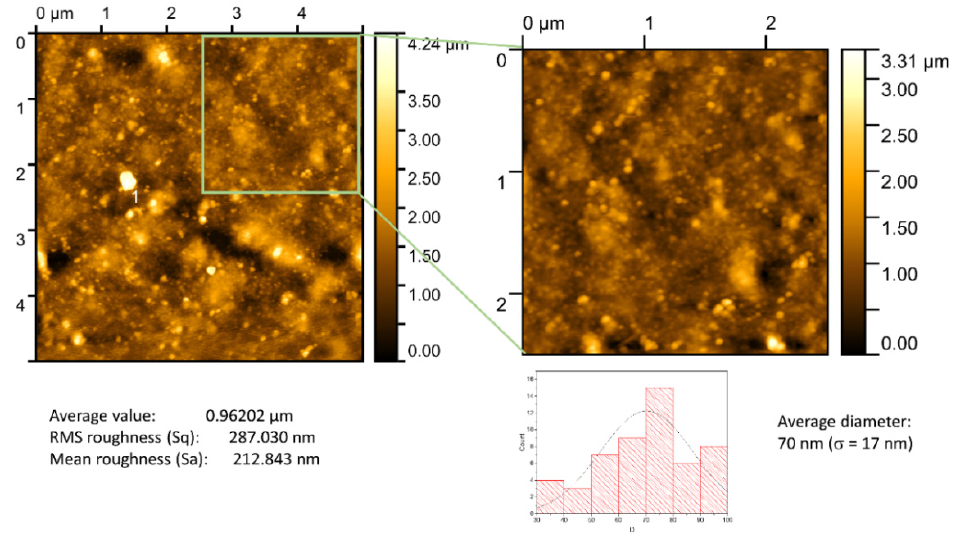
Figure 4. AFM surface topography of chitosan (0.5%)/Au-NPs membrane and its surface characteristics analysis, including the average height value, RMS roughness (Sq), mean roughness (Sa), and the average diameter of NPs.